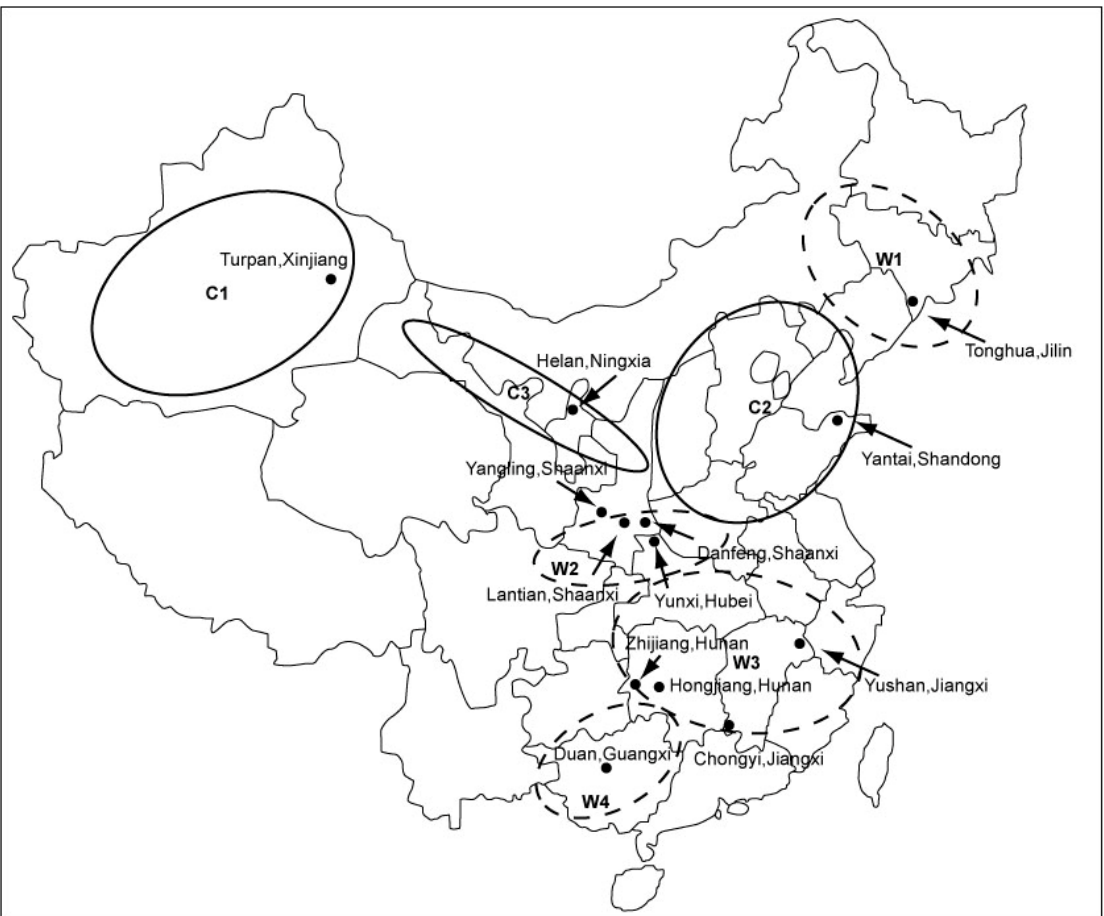
Figure 1. Geographical location of the sampling sites (black